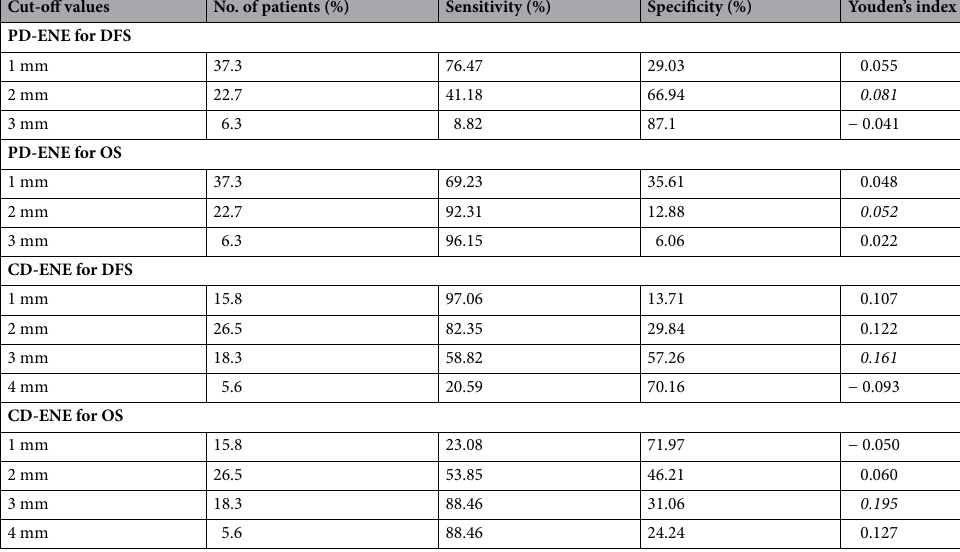
Table 1. Comparisons between different cut-off values of PD-ENE. PD-ENE perpendicular diameter of extra- nodal extension; CD-ENE circumferential diameter of extra-nodal extension; DFS disease recurrence free survival; OS overall survival; Youden’s Index = sensitivity + specificity − 1. The values in italic are the maximum Youden’s index.